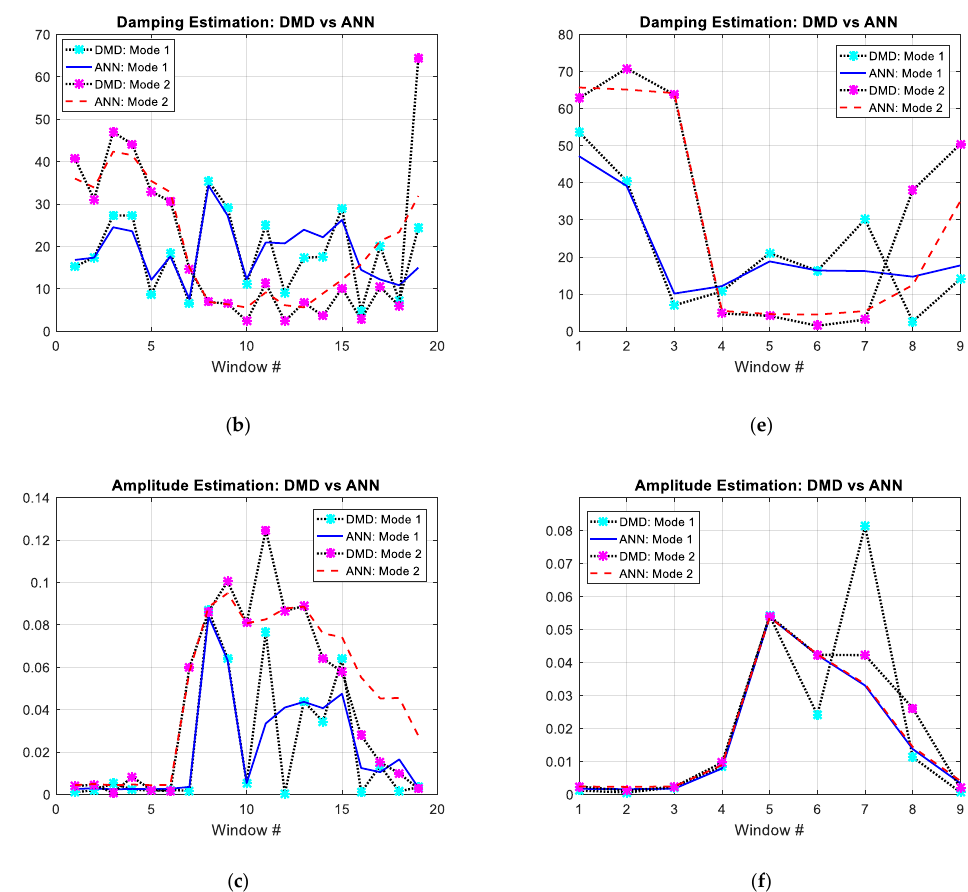
Figure 10. Estimates produced by DMD versus the estimates produced by the ANN approach for the case of dataset DS1 for a length of the data frame of 30 s: ( a ) frequency, ( b ) damping, ( c ) amplitude. Same comparisons evaluated for a length of the data frame of 60 s: ( d ) frequency, ( e ) damping, ( f ) amplitude.